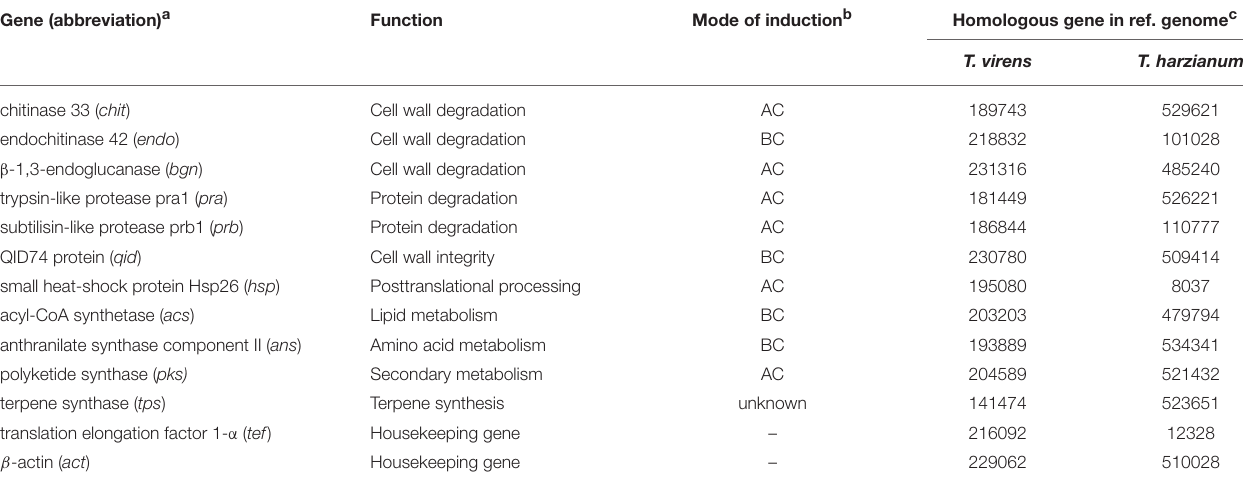
TABLE 2 | Trichoderma genes chosen for expression analysis.